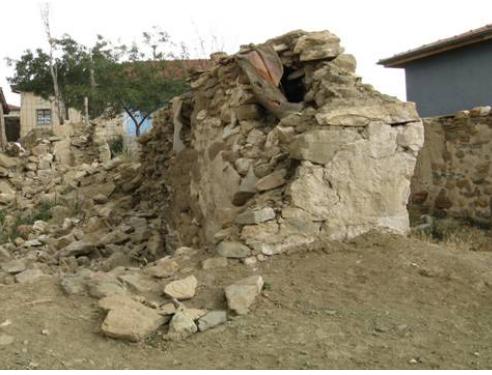
Fig. 13. A masonry wall with cavity and mud mortar. Fig. 13 A masonry wall with cavity and mud mortar